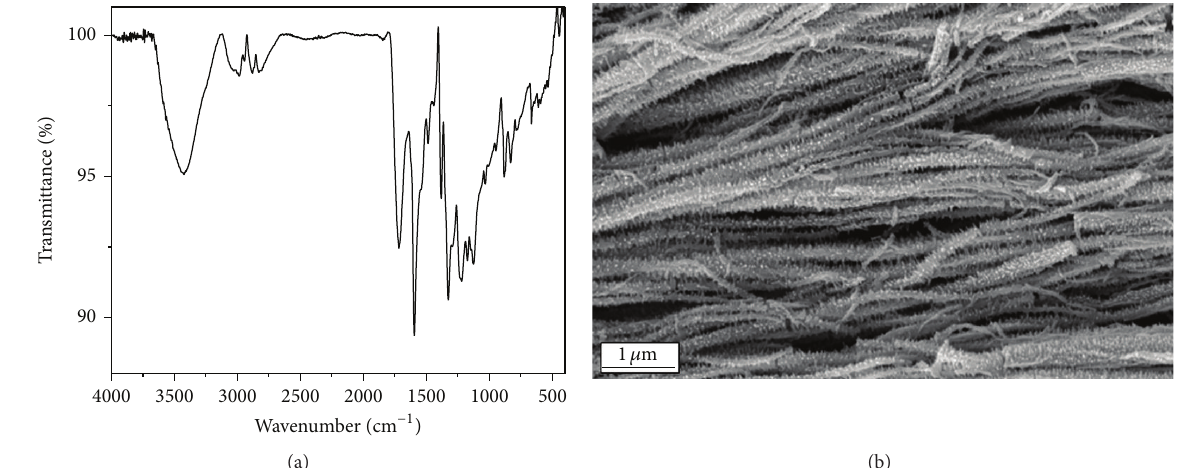
Figure 4: (a) IR spectrum of wsCNRs and MB composites isolated from the system. (b) FESEM image of wsCNRs after adsorption of MB confirming its interactions.